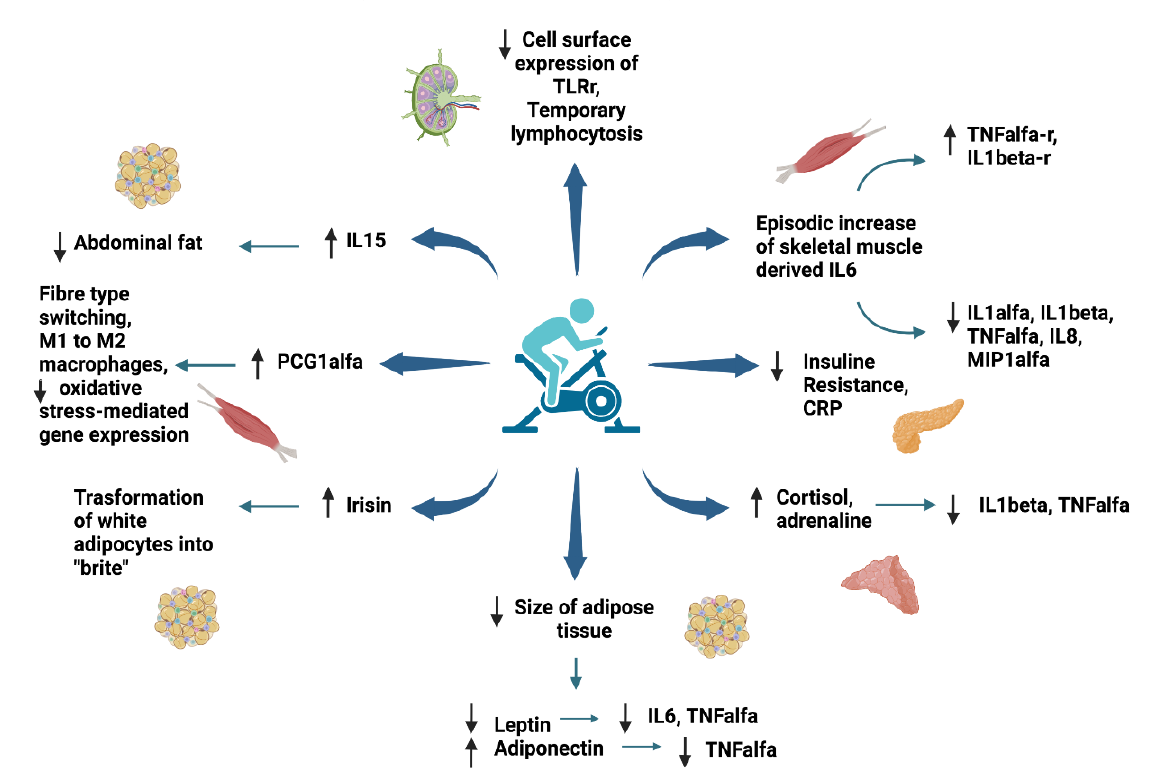
Figure 2. Anti-inflammatory effect of exercise in children and adolescents with obesity (created using Biorender). TNF = tumor necrosis factor; IL = interleukin; M = macrophages; TLR = Toll-like receptor; CRP = C-reactive protein; MIP = macrophage inflammatory protein.